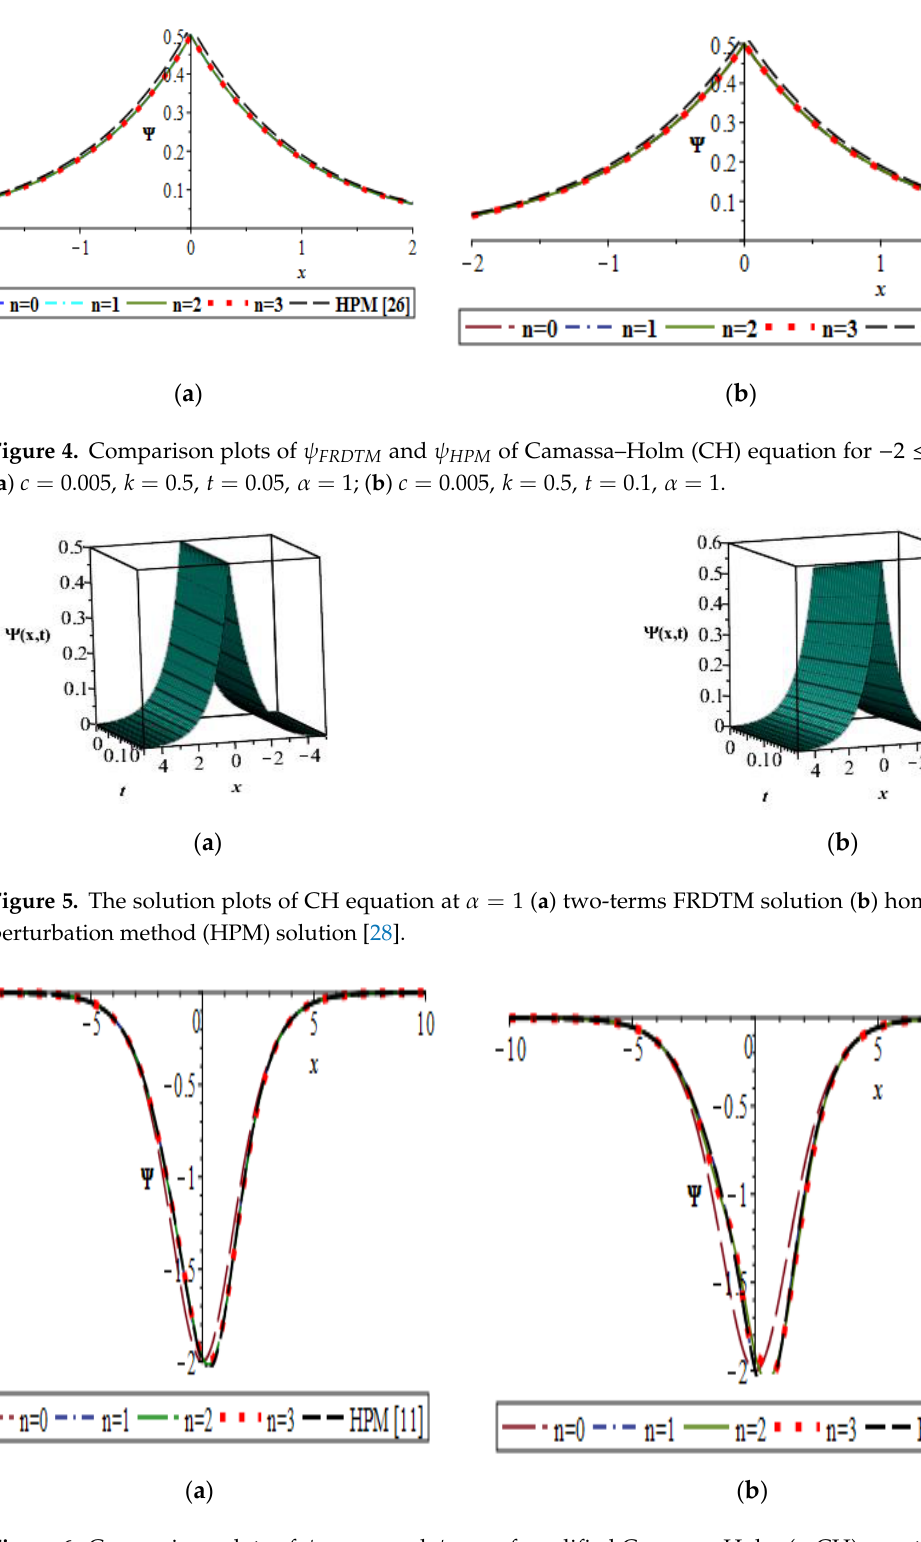
( b ) Figure 7. The solution plots of mCH equation at 1 = ( a ) two-terms FRDTM solution ( b ) HPM solution [11]. Table 3. The two term FRDTM approximation results of mCH equation with HPM [11] for